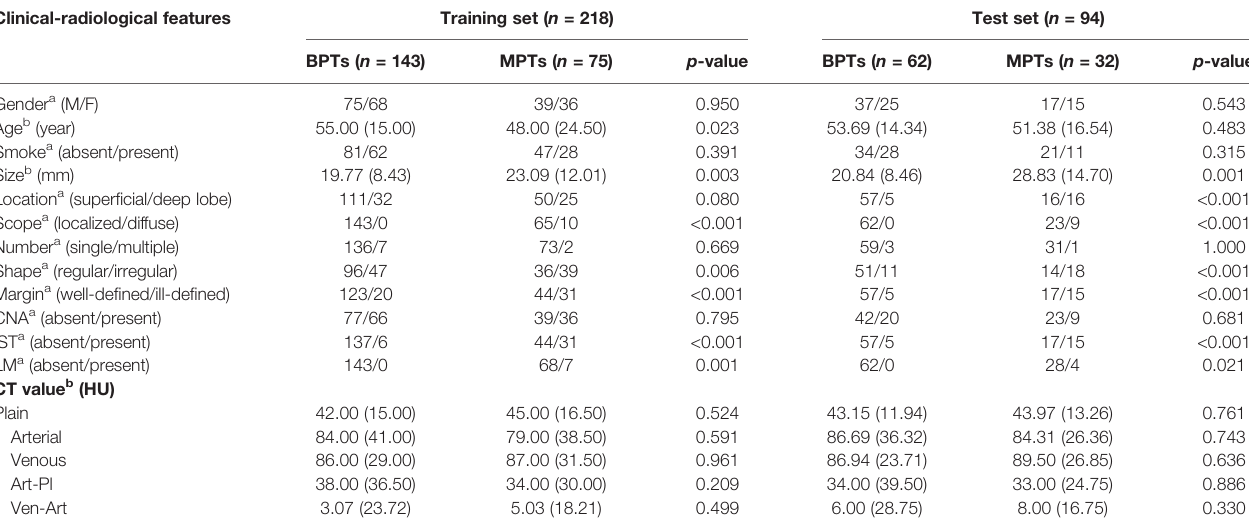
TABLE 1 | Clinical-radiological features of the training and test sets. Clinical-radiological